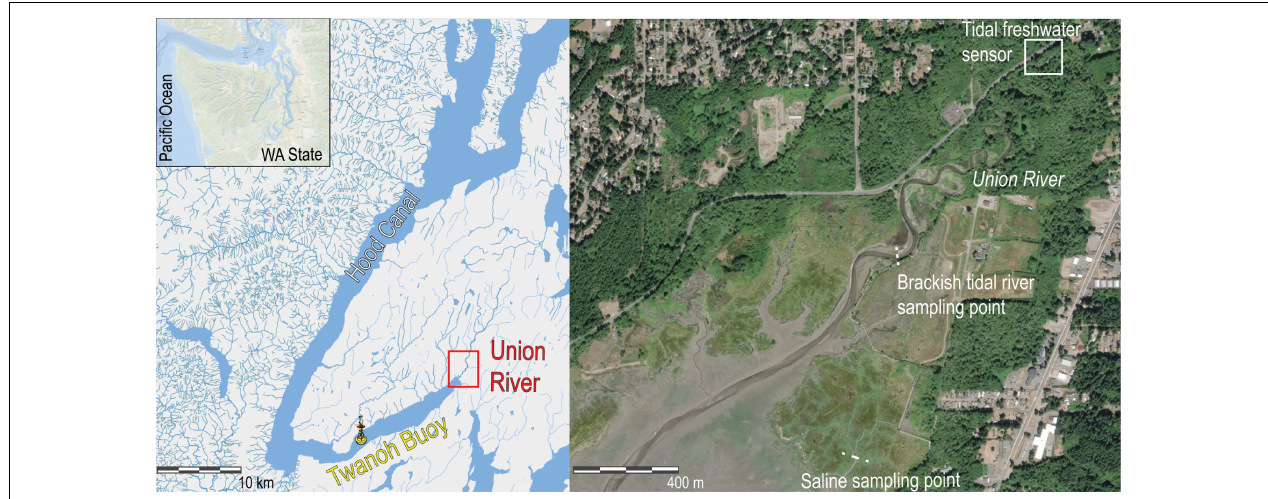
FIGURE 1 | Location of the Union River (47.452050 N, -122.833807 W) and Twanoh Buoy (47.375 N, -123.008 W) in the Puget Sound of Washington state, United States. Map was created using ArcGIS 10.5 software (ESRI, 2017). Coordinate System: GCS WGS